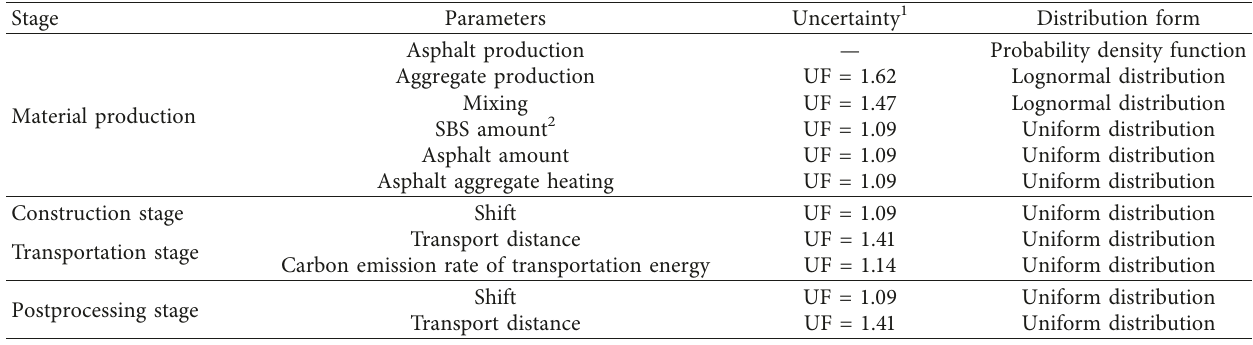
Table 6: Parameter uncertainties of the asphalt pavement LCA model.